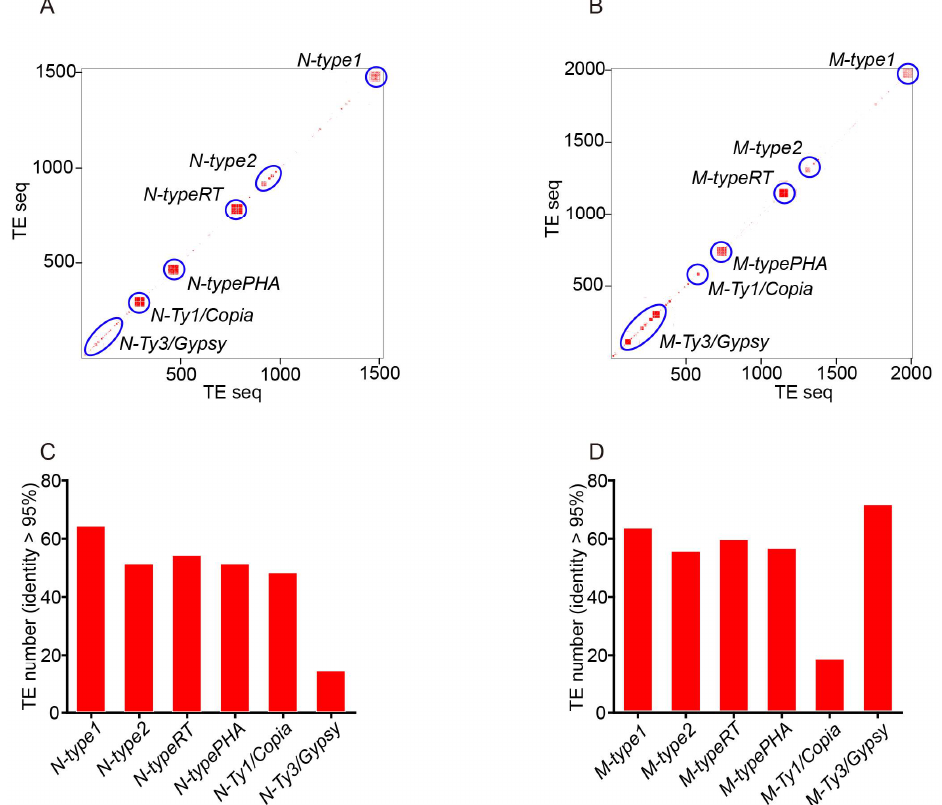
Figure 1. The Nip and MH63 TE ORF matrix and clusters. ( A , B ) Six TE ORF clusters type1 , type2 , typeRT , typePHA , Ty1 / Copia , and Ty3 / Gypsy with identities of over 95% observed at the TE matrix diagonals in the Nip and MH63 genomes, respectively, where N indicates Nip and M indicates MH63. ( C ) TE numbers with identities of over 95% for each cluster in Nip, N-type1 (64 TEs), N-type2 (51 TEs), N-typeRT (54 TEs), N-typePHA (51 TEs), N-Ty1 / Copia (48 TEs), N-Ty3 / Gypsy (14 TEs). ( D ) TE numbers with an identity over 95% for each cluster in MH63, M-type1 (63 TEs), M-type2 (55 TEs), M-typeRT (59 TEs), M-typePHA (56 TEs), M-Ty1 / Copia (18 TEs), and M-Ty3 / Gypsy (71